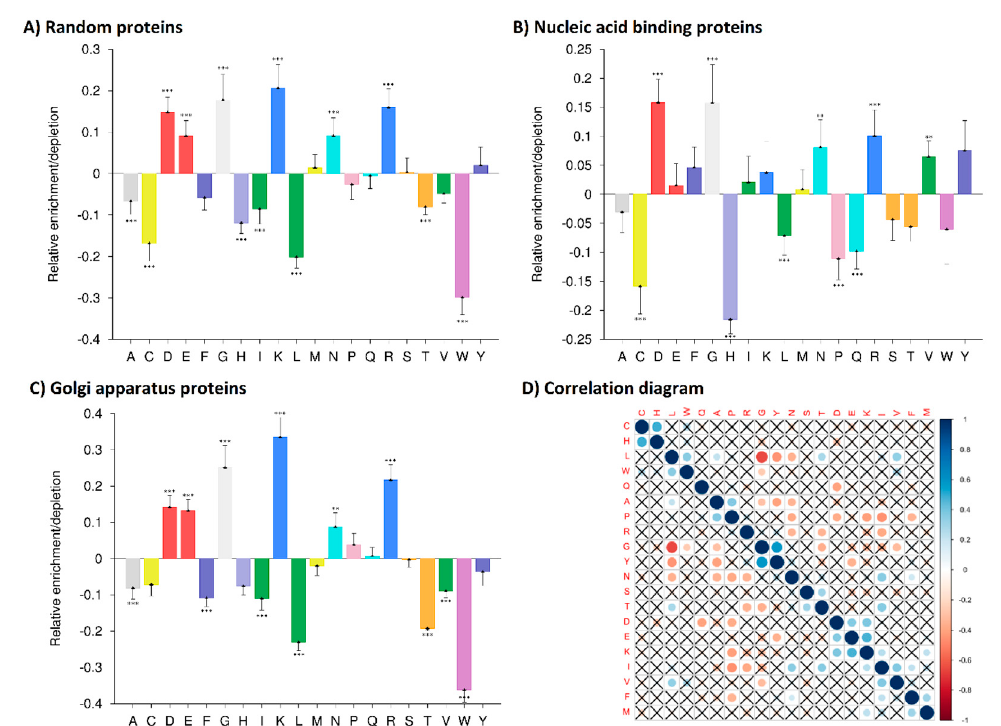
Figure 2. Relative enrichment or depletion of individual amino acids in 77 quadruplex binding proteins versus ( A ) 5000 randomly subsampled human proteins from UNIPROT database, ( B ) 15,224 nucleic acid binding proteins including isoforms from Ensembl Biomart, ( C ) 2565 Golgi apparatus proteins including isoforms from Ensembl Biomart. The analyses were performed using Composition Profiler (10,000 bootstrap iterations with Bonferroni correction for testing multiple hypotheses). Using Bonferroni correction, only values lower than 0.0025 were taken as significant (* p < 0.0025; ** p < 0.0010; *** p < 0.0001). p -values are shown in Supplementary material S13. ( D ) Correlation diagram of amino acid content in quadruplex binding proteins. Non-significant correlations ( p -values > 0.05) are crossed out.